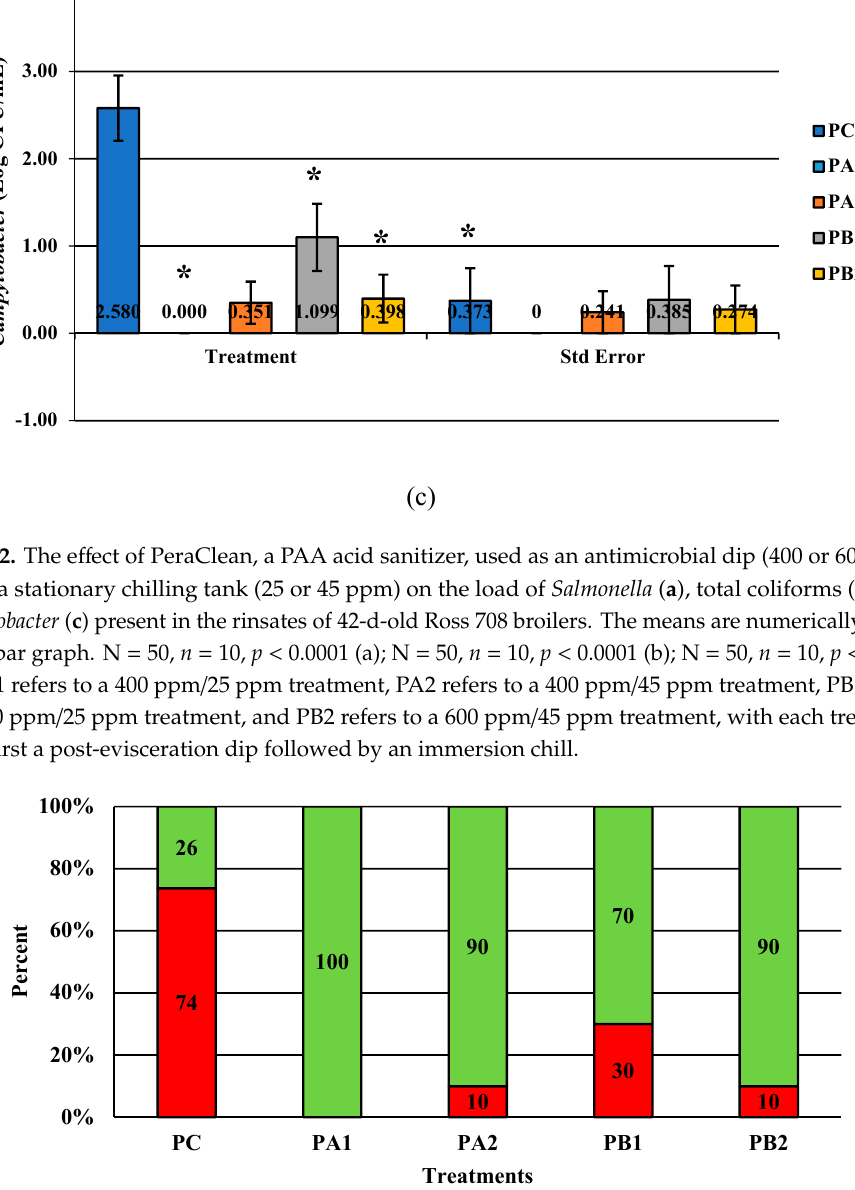
Figure 4. The effect of Competitor 1, a PAA sanitizer used as an antimicrobial dip (400 or 600 ppm) and in a stationary chilling tank (25 or 45 ppm) on the load of Campylobacter present in the rinsates of 42-d-old Ross 708 broilers. The means are numerically stated on the bar graph. N = 50, n = 10, p = 0.0022. CA1 refers to a 400 ppm/25 ppm treatment, CA2 refers to a 400 ppm/45 ppm treatment, CB1 refers to a 600 ppm/25 ppm treatment, and CB2 refers to a 600 ppm/45 ppm treatment, with each treatment being first a post-evisceration dip followed by an immersion chill.